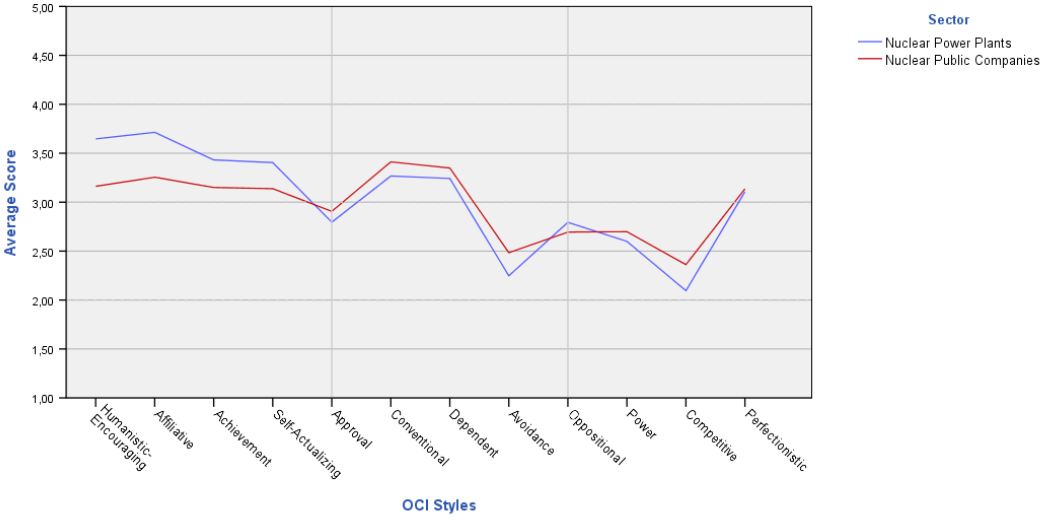
Figure 5. OCI styles averages for Spanish nuclear sector.